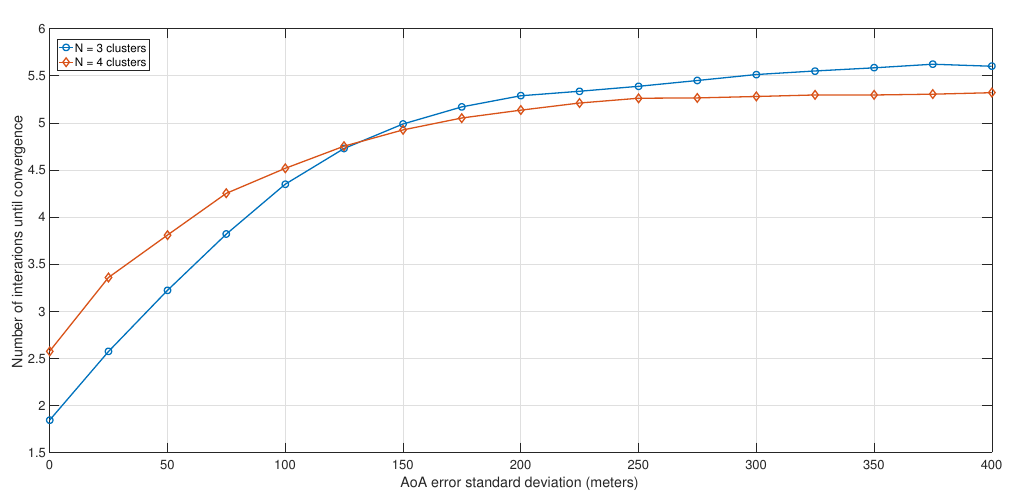
Figure 13. Number of iterations until convergence, as a function of the AoA error.